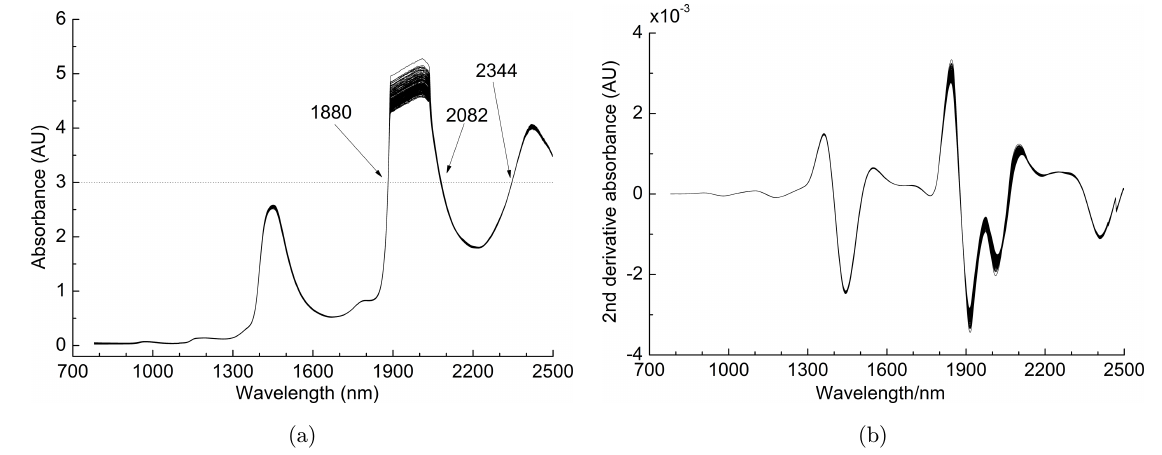
Fig. 1. NIR spectra of 210 serum samples: (a) raw spectra and (b) NDF spectra ð d ¼ 2, s ¼ 33, g ¼ 15 Þ . Table 1. Prediction e®ects of the PLS and Norris – PLS models in modeling.